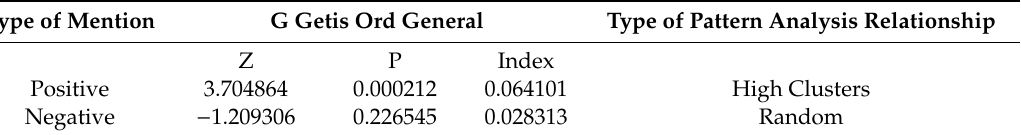
Table 9. G Getis Ord test on